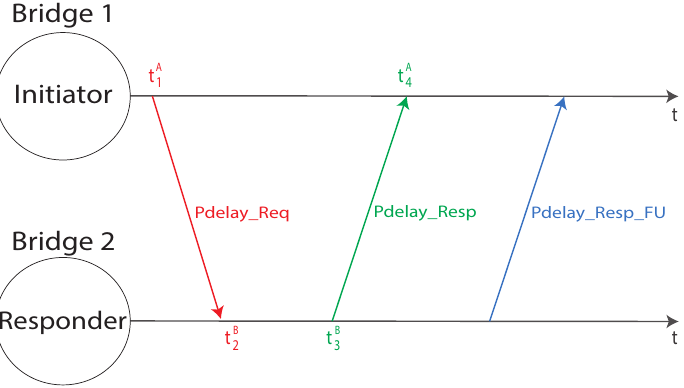
Figure 7. The propagation delay measurement: messages exchanged between two stations, A and